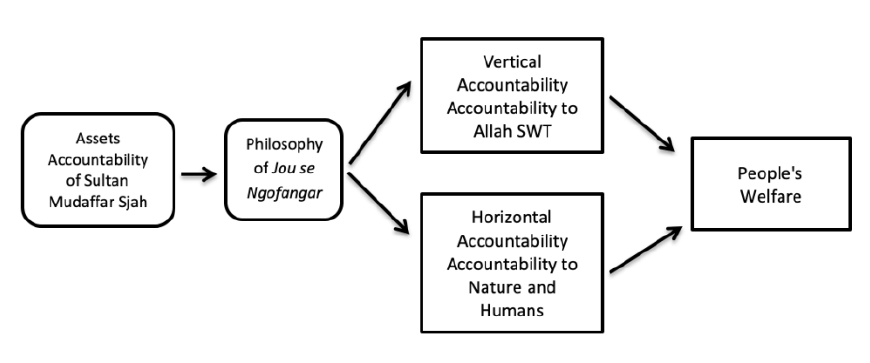
Figure 2: Results of analysis and data processing on Sultan Mudaffar Sjah II's Accountability